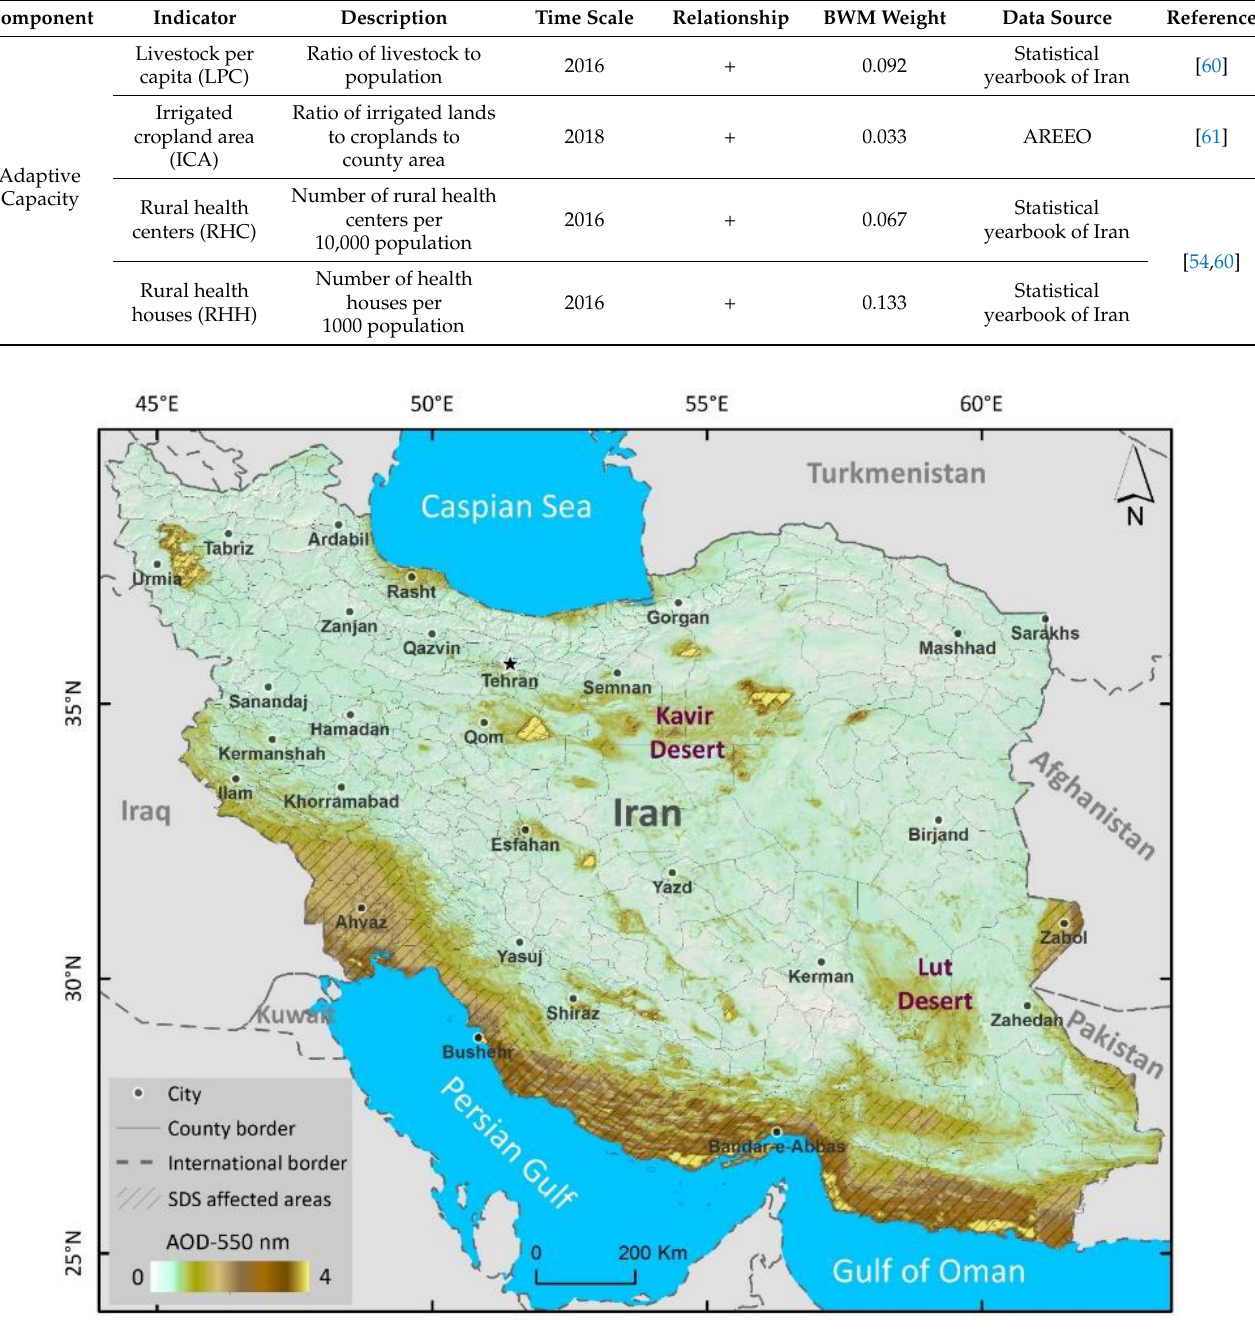
Figure 2. Iran county map (a number of 429) and SDS-affected areas determined using the proposed threshold by [16], i.e., average MODIS AOD > 0.19 from 2000 to 2022.